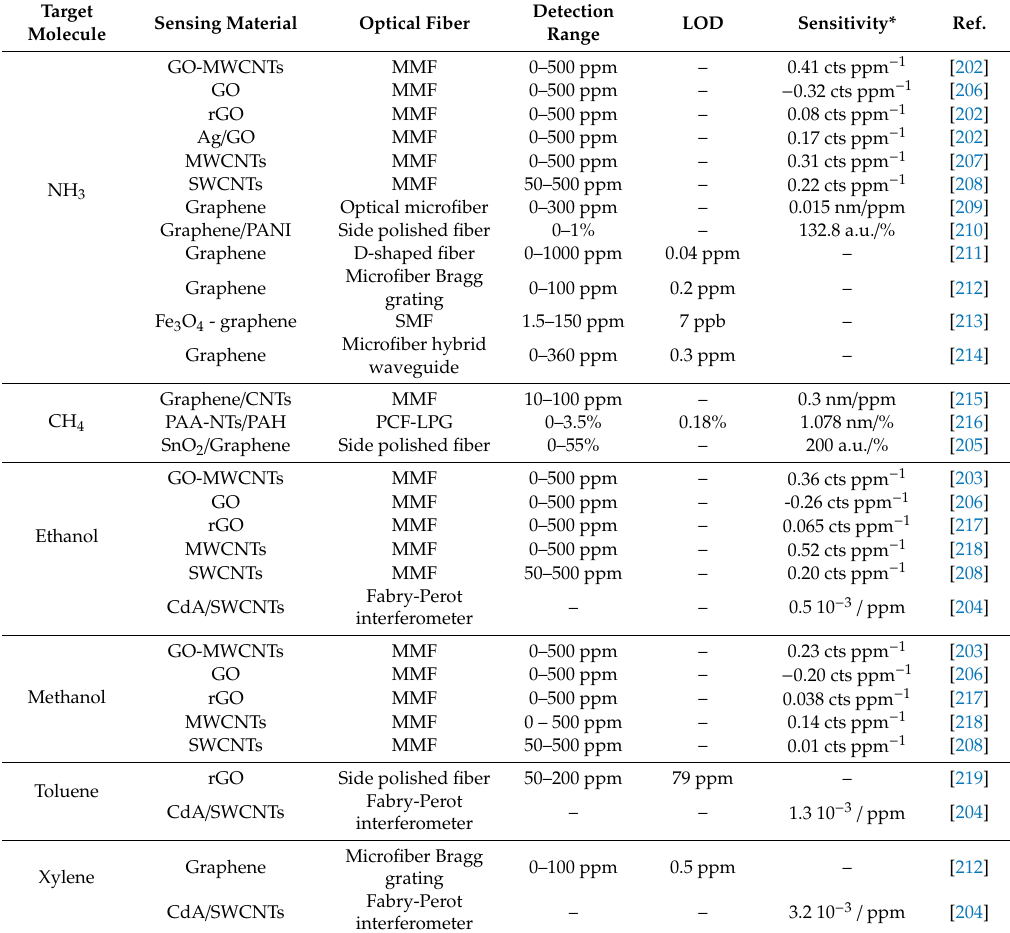
Table 7. Summary of carbon allotrope-based OFS for VOCs